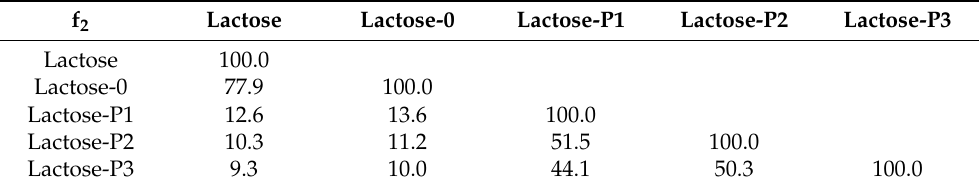
Table 2. The f 2 of capsules containing curcumin-loaded lactose studied in this work. f 2 Lactose Lactose-0 Lactose-P1 Lactose-P2 Lactose-P3 Lactose 100.0 Lactose-0 77.9 100.0